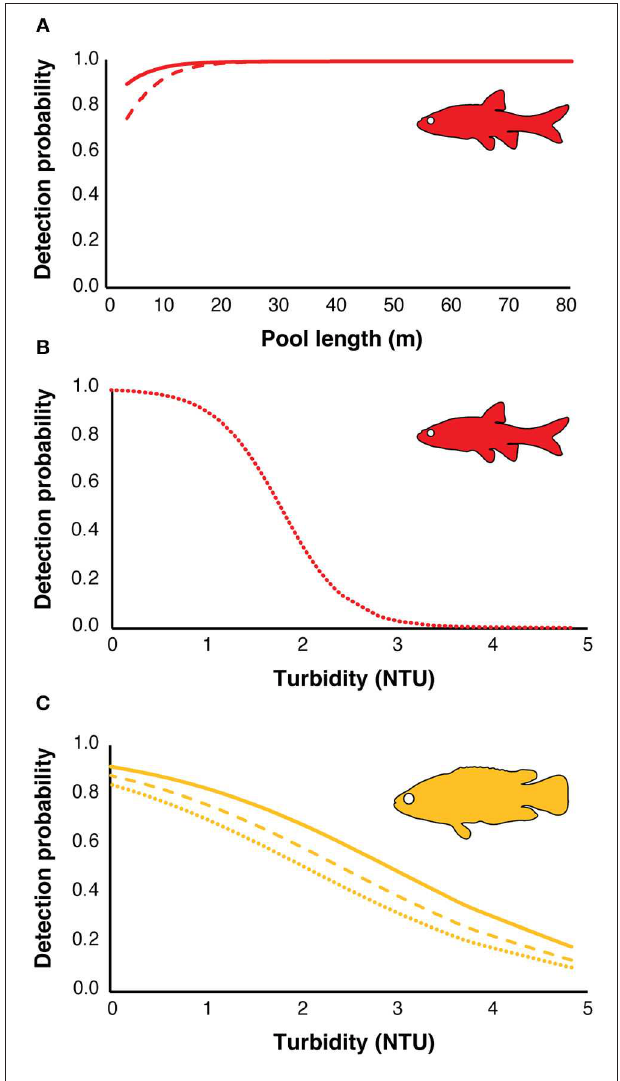
FIGURE 4 | Effect of habitat variables on the estimated detection probabilities from the top models of the three methods for redfins (red) and Cape Kurper (yellow): (A) detection probability of underwater cameras (solid line), snorkel surveys (dashed line) against pool length (m) for redfins; (B) detection probability of eDNA for redfins (dotted line), (C) detection probability of underwater cameras (solid line), snorkel surveys (dashed line), and eDNA (dotted line) against water turbidity (NTU) for Cape